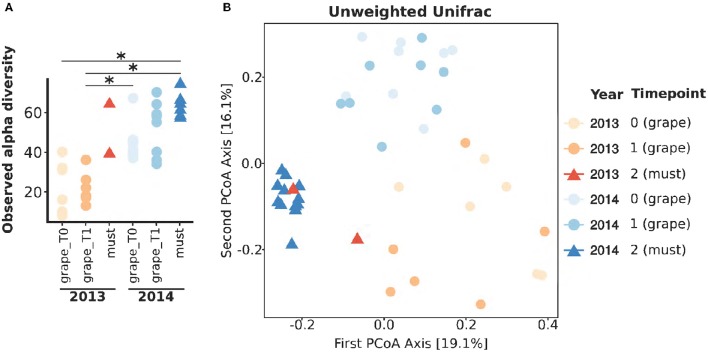
Fungal population diversities in Corvina grapes and fresh musts. (A) Observed OTUs of fungal populations present in grape and must samples. *Wilcoxon-Mann-Whitney FDR < 0.05. (B) First two coordinates if the Principal Coordinates Analysis (PCoA) carried out on samples distances calculated with the unweighted UniFrac metric.